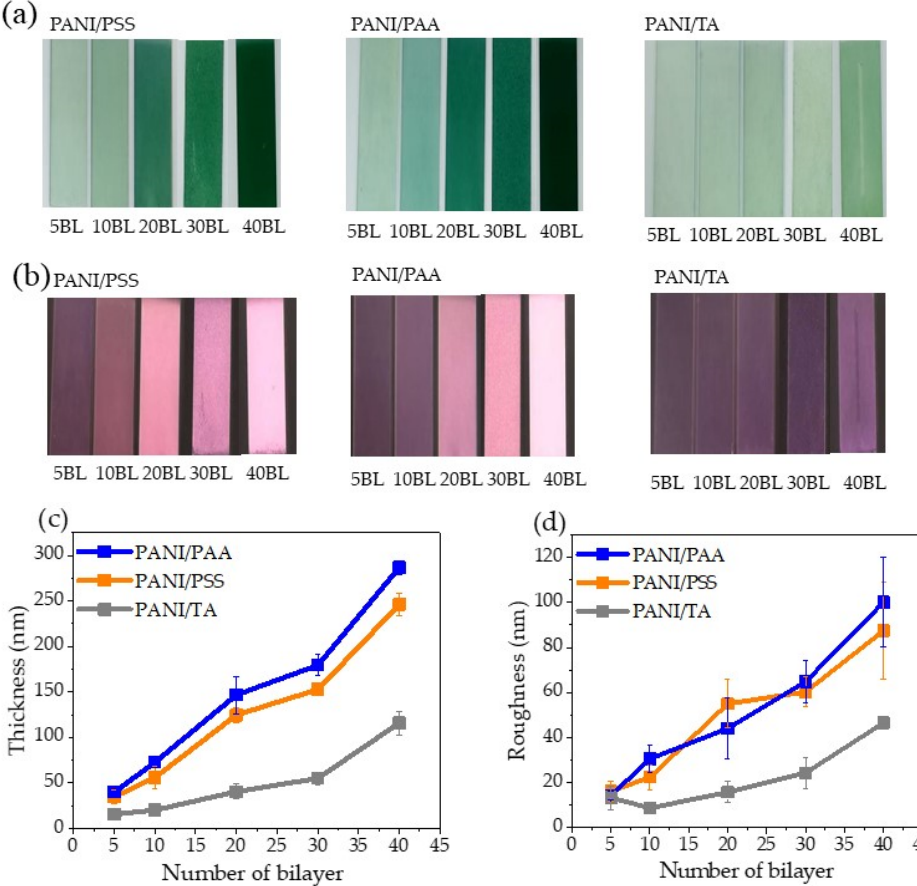
Figure 1. Photographs of the polyacid-doped PANI-based film: ( a , b ) the negative images, ( c ) growth profiles, and ( d ) roughness profiles of the LbL films of different bilayers (BL).